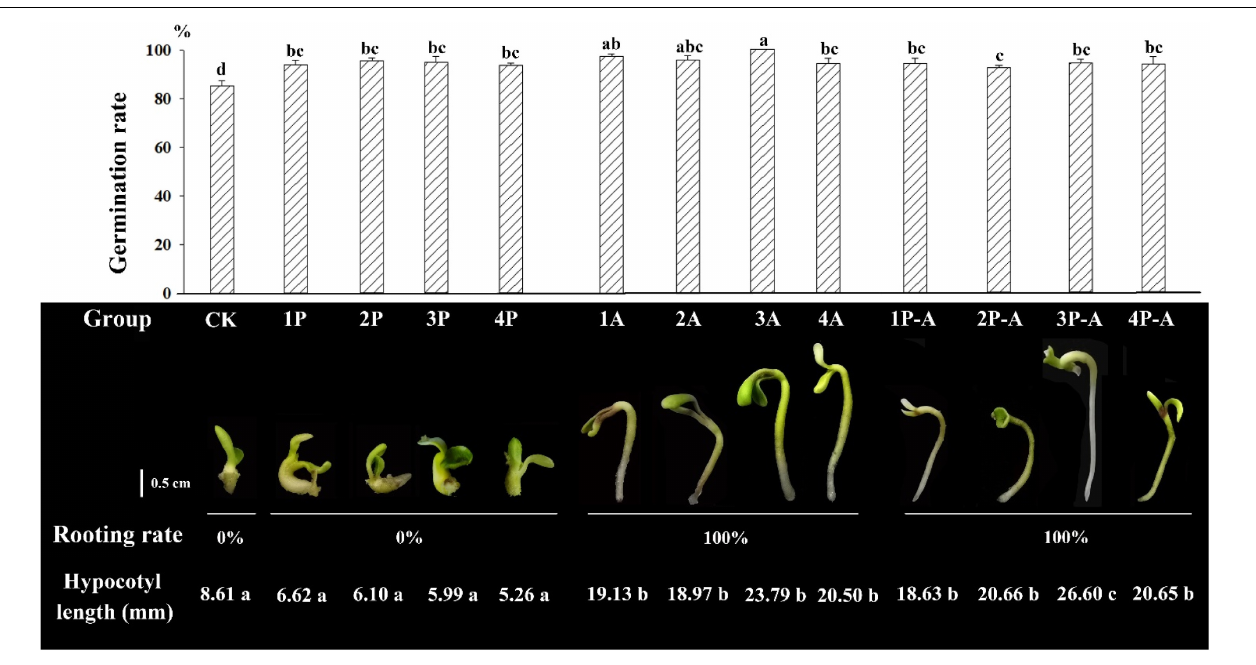
FIGURE 1 | Germination rate, rooting rate, hypocotyl length, and seedling morphology of seed embryos treated with different anti-browning agents. CK represents the control group; 1–4P represents the addition of PVP anti-browning agent groups with concentrations of 1.5, 2.0, 2.5, and 3.0 g • L − 1 , respectively. 1–4A represents the addition of AC anti-browning agent with concentrations of 0.3, 0.6, 0.9, and 2.0 g • L − 1 , respectively. 1–4P-A represents the groups added with 1.5, 2.0, 2.5, and 3.0 g • L − 1 PVP and 0.9 g • L − 1 AC anti-browning agent combinations, respectively. Rooting rate (%) = (Number of rooting seedlings/Number of germinated seedlings) × 100%. Different lowercase letters represent significant difference at 0.01 level (Duncan, P =